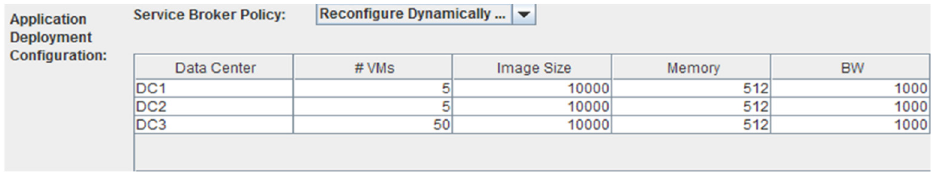
Figure 9. Application deployment configuration of Data Centers 1 to 3 based on ORT SBP.